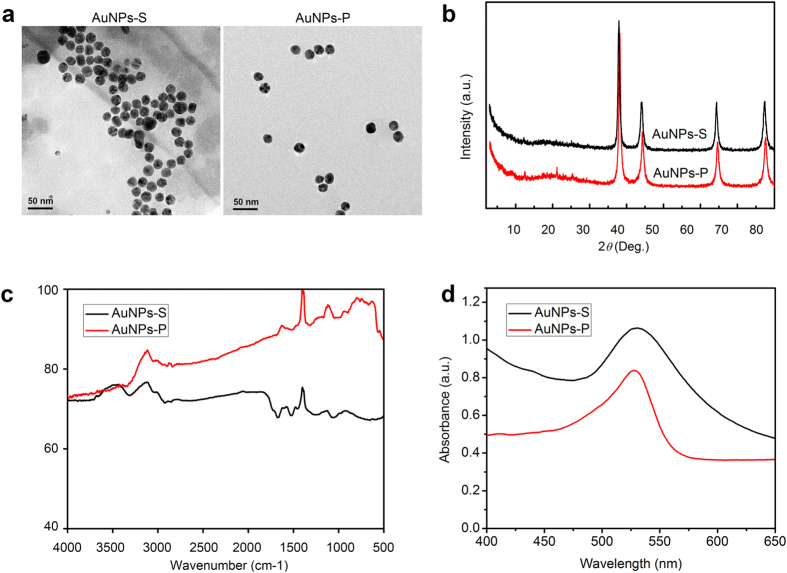
Characterization of the as-synthesized AuNPs.(a) TEM observation of AuNPs-S (synthesized using apple extract by Sharma’s method) and AuNPs-P (synthesized using trisodium citrate by Polte’s method). (b) X-ray diffraction patterns. (c) FI-TR analysis. (d) UV-vis spectra.